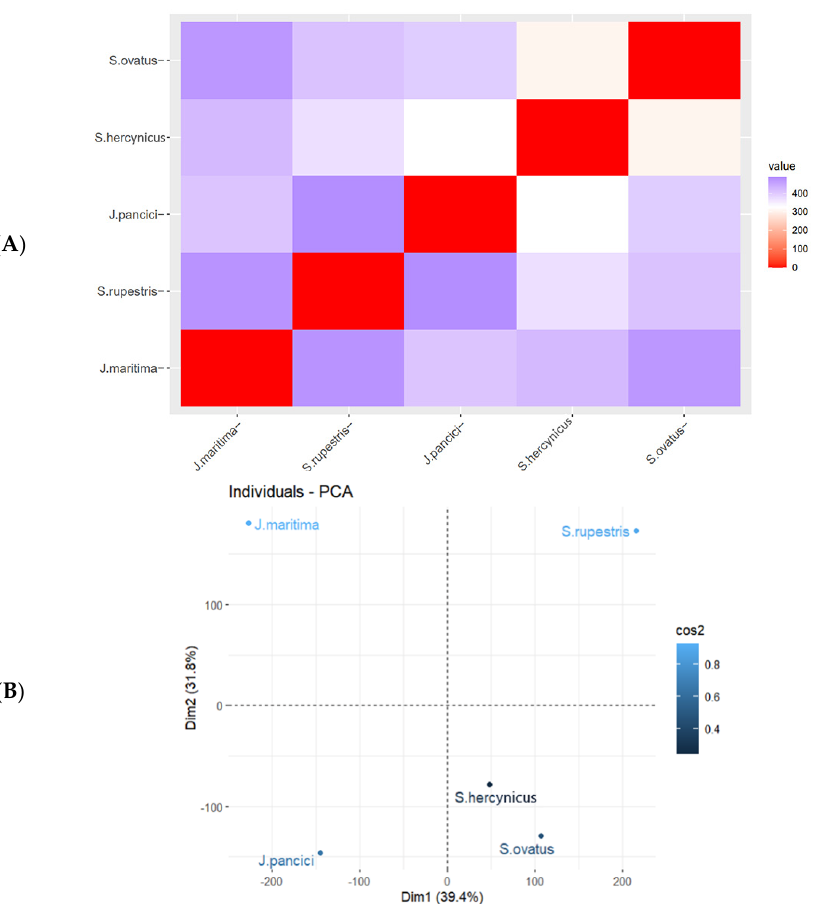
Figure 4. ( A ): Heatmap of the Euclidean distance using the normalized (0 to 100) AUC of identified compounds. In case a compound was not detected in an extract, the AUC for that compound was set to 0; ( B ): Principal component analysis (PCA) (cos2—quality of